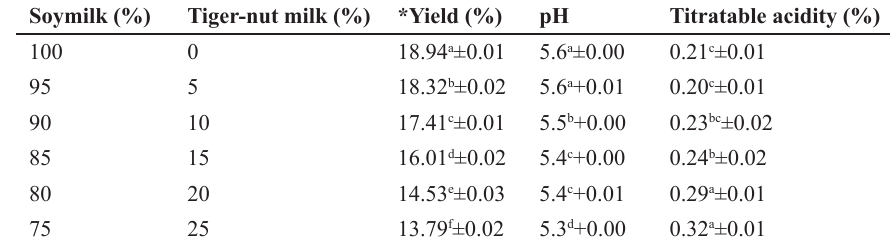
Table 1: Yield, pH and titratable acidity of soy-tiger-nut cheese. Soymilk (%)